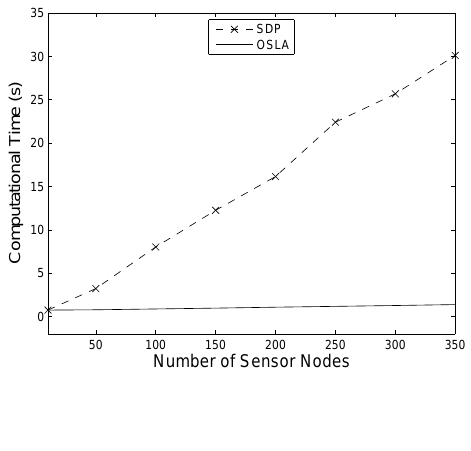
Figure 9. Variation of the computational cost required by the algorithms when the number of sensor nodes increases with 4-State Markov